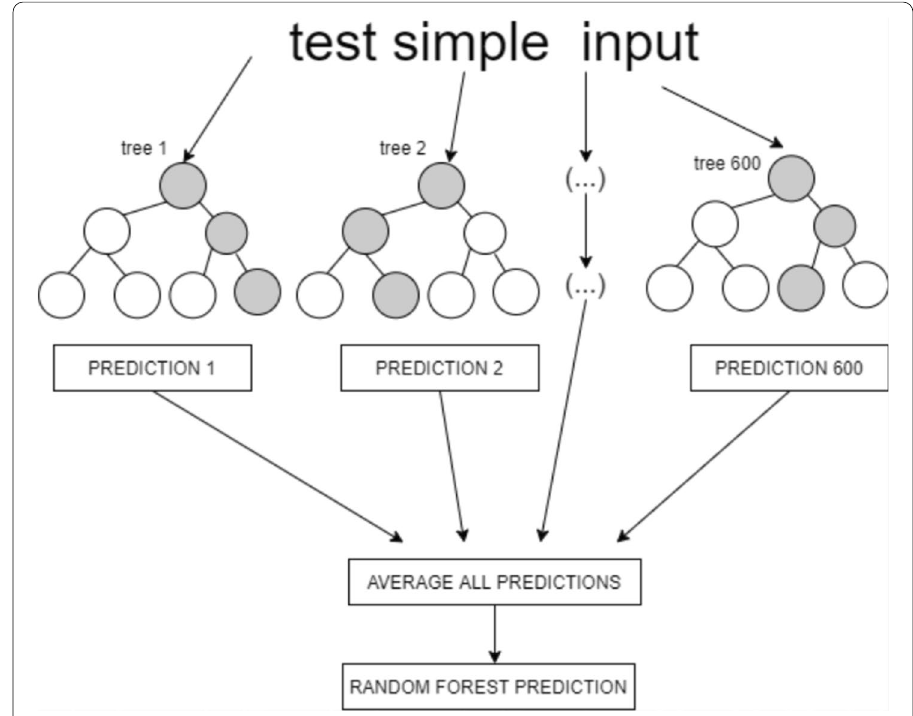
Fig. 3 RF Algorithm